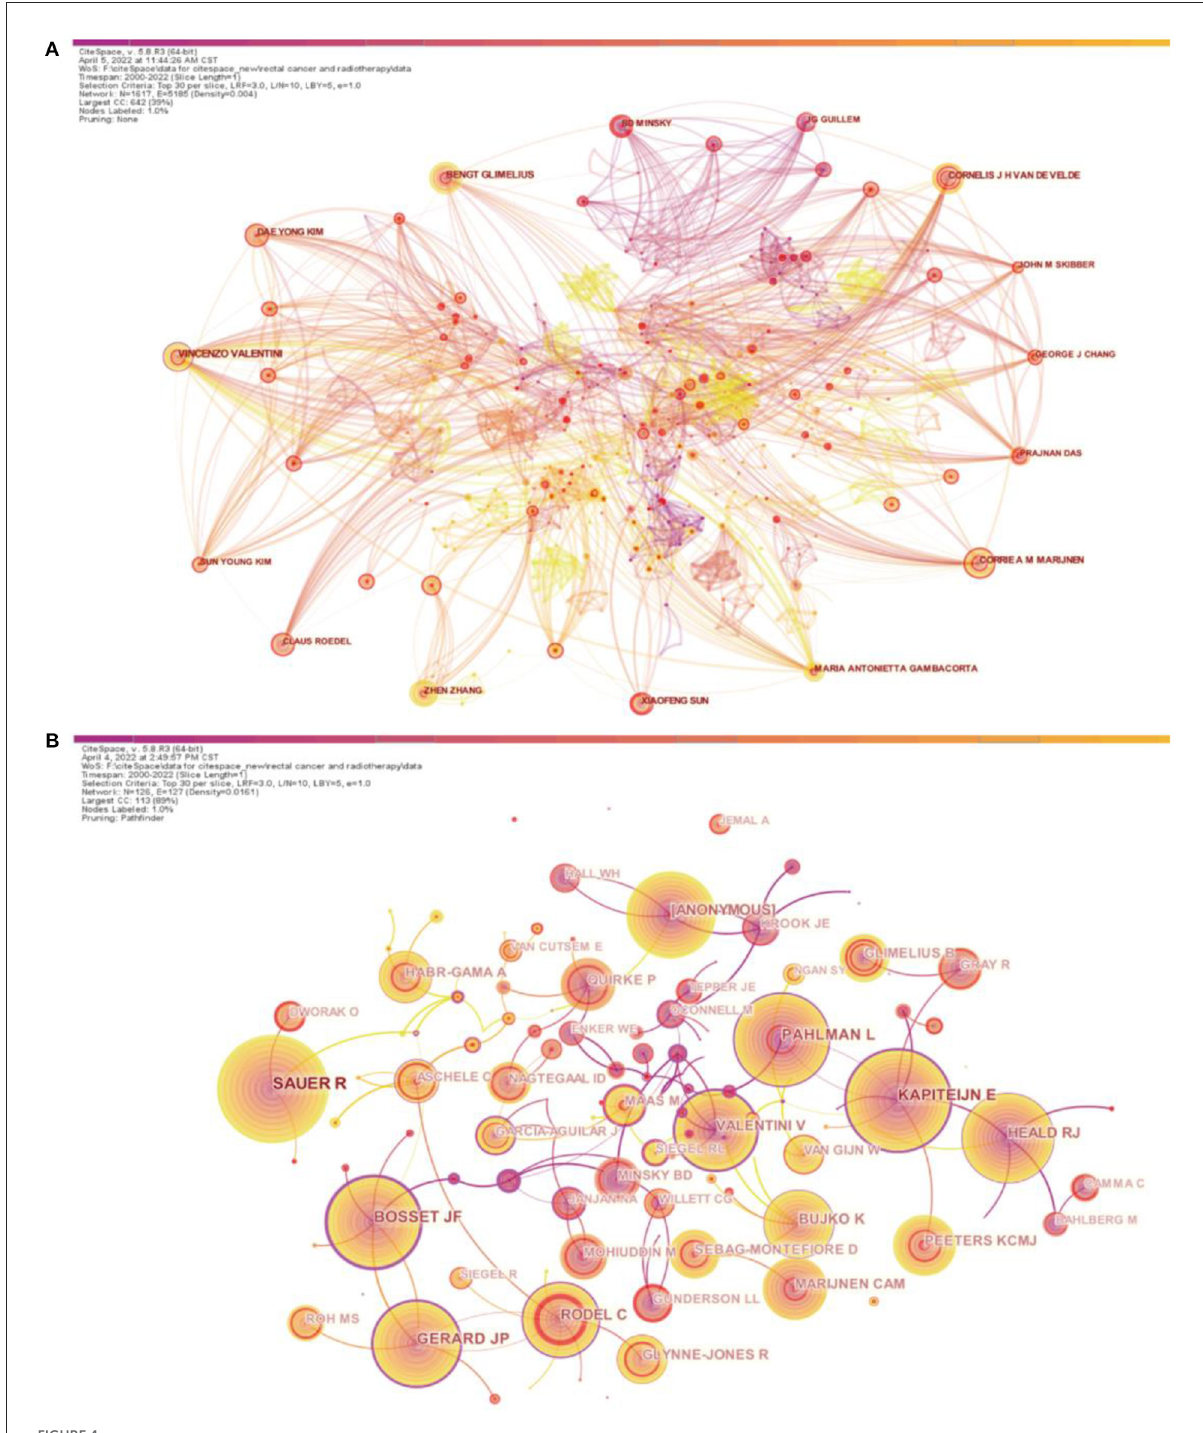
FIGURE4 Analysis of authors and co-cited authors involved in research on radiotherapy for rectal cancer. (A) Network diagram showing author links (Timespan: 2000–2022; Slice Length: 1; Selection Criteria: Top30 per slice; Network: N = 1617, E = 5,185; Density: 0.004; Largest CC:642; Nodes Labeled:1.0%; Pruning: None). (B) Network diagram showing co-cited author links (Timespan: 2000–2022; Slice Length: 1; Selection Criteria: Top30 per slice; Network: N = 126, E = 127; Density: 0.0161; Largest CC:113; Nodes Labeled:1.0%; Pruning: